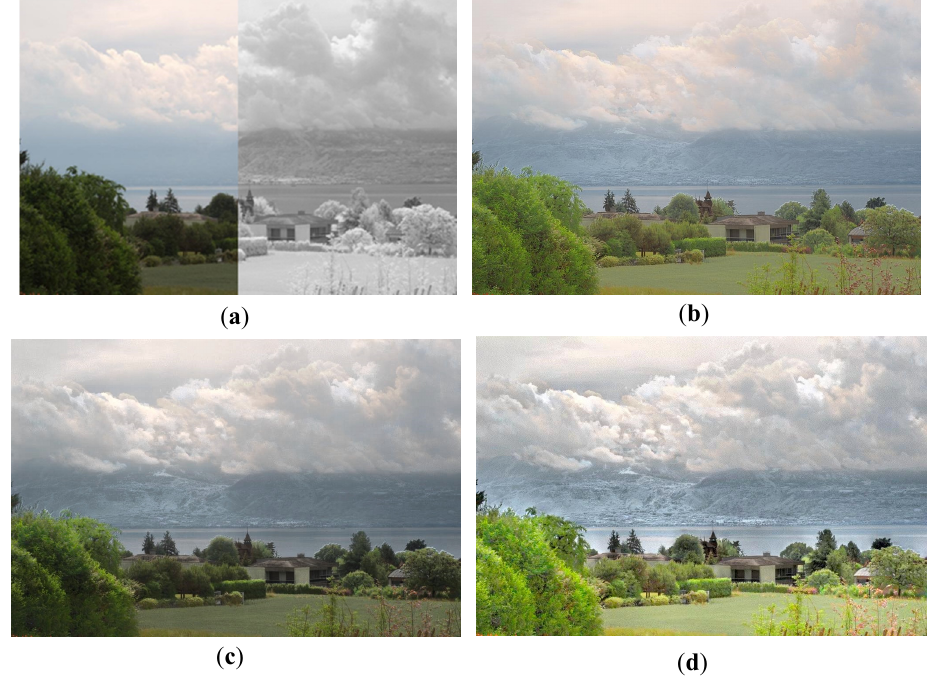
Figure 6. Input image pair and resulting images: ( a ) input VIS and NIR images, ( b ) Laplacian pyramid fusion [1], ( c ) low-rank fusion [5], and ( d ) the proposed method.